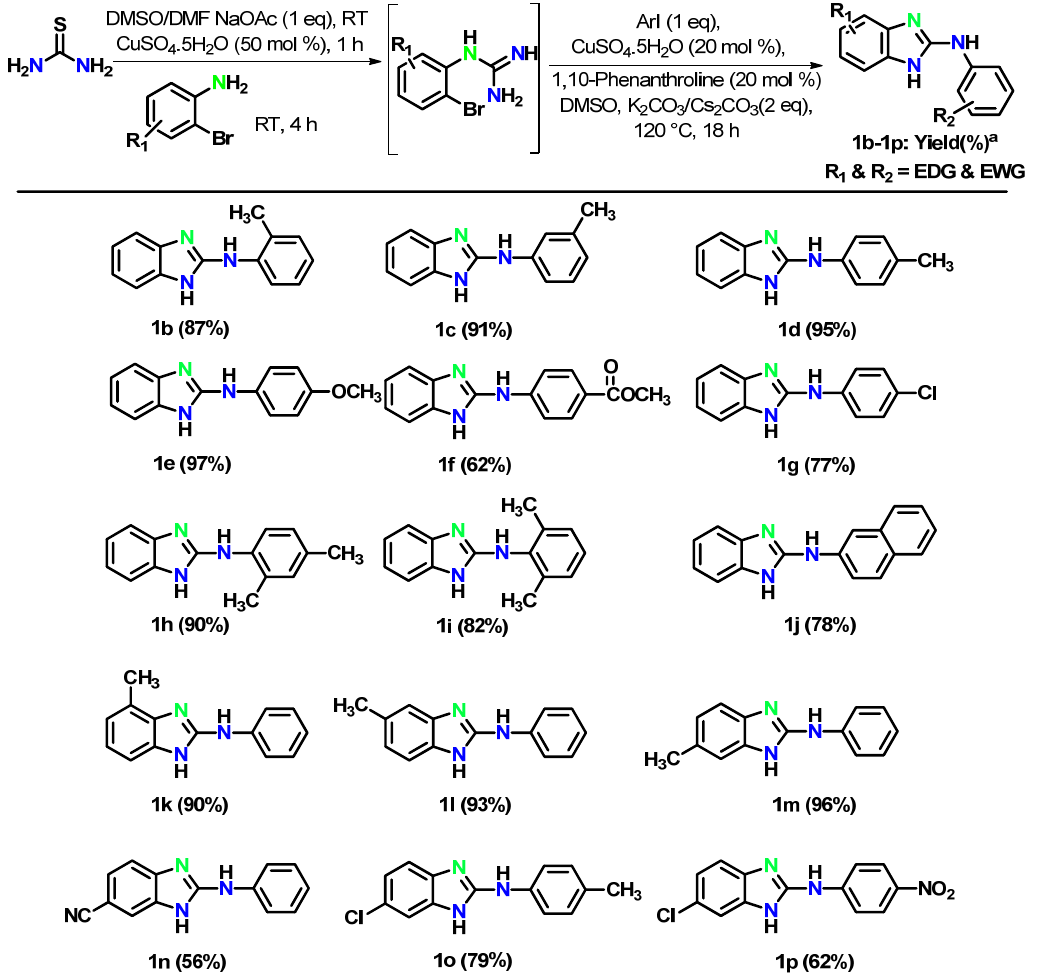
Figure 2. Substrate scope evaluation; Reaction conditions: thiourea (1 mmol); DMSO (2 mL); NaOAc (1 equiv); CuSO 4 .5H 2 O (50 mol%), 1 h, room temperature; 2-bromo aniline/substituted 2-bromo aniline (2 mmol), room temperature, 4 h; Next, ArI (1 mmol); CuSO 4 .5H 2 O (20 mol%); 1,10-Phenanthroline (20 mol%); K 2 CO 3 (2 mmol); 18 h; 120 °C; a Isolated yield.